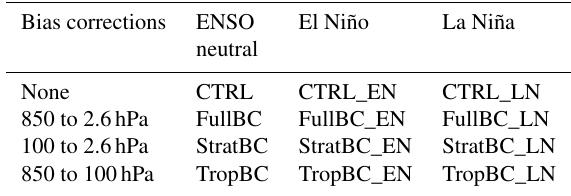
Table 1. Experiment details and run